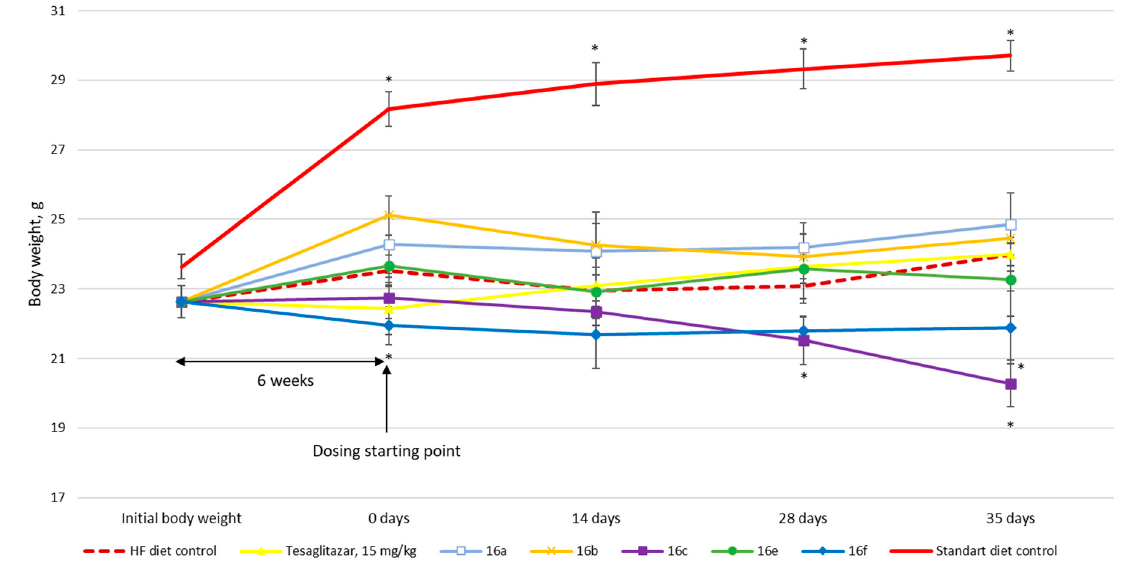
Figure 3. Dynamics of changes in body weight of animals during the experiment. * p < 0.05 compare to HF diet control. 6 week—period on HF-diet prior to introduction of testing compounds. Dosing starting point—first introduction of